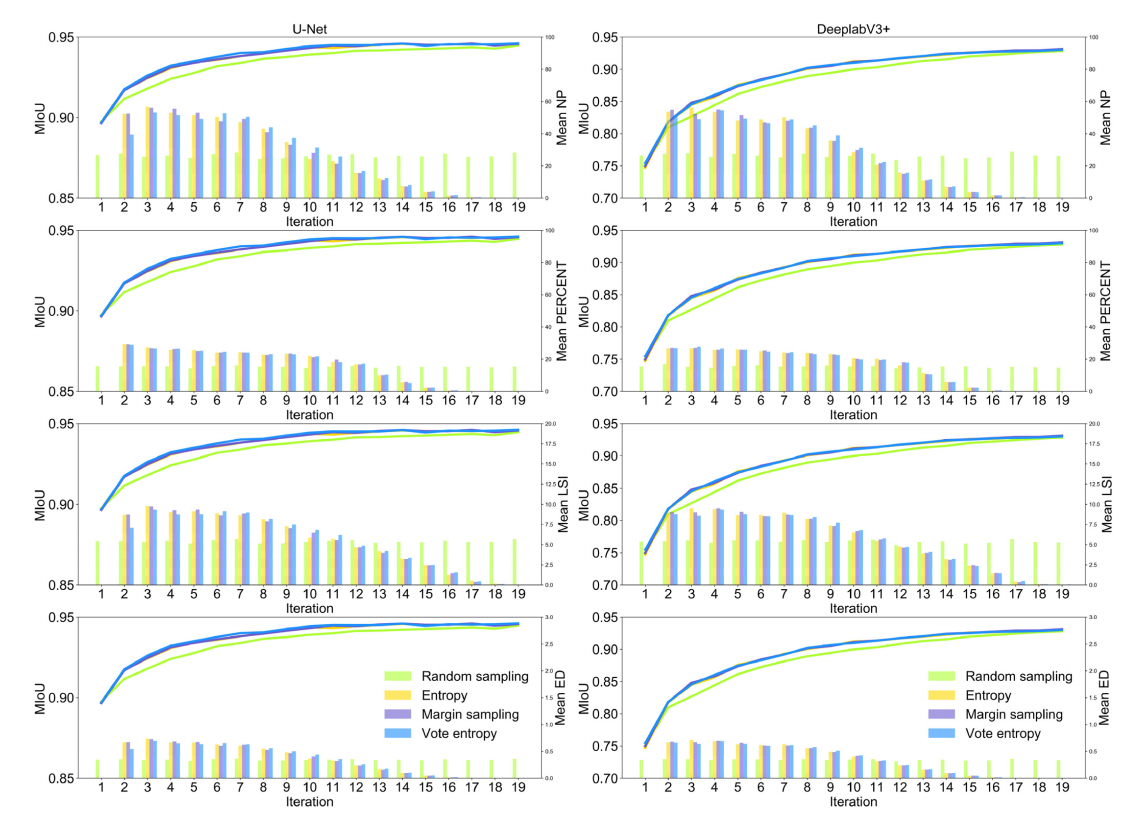
Figure 8. Landscape patterns of selected tiles in each iteration via three active learning strategies and random sampling from WHU aerial dataset. The x -axis indicates the iterations of model training. The left y -axis indicates the value of mIoU in each iteration. The right y -axis indicates the value of the landscape metrics computed based on selected image tiles in each iteration.